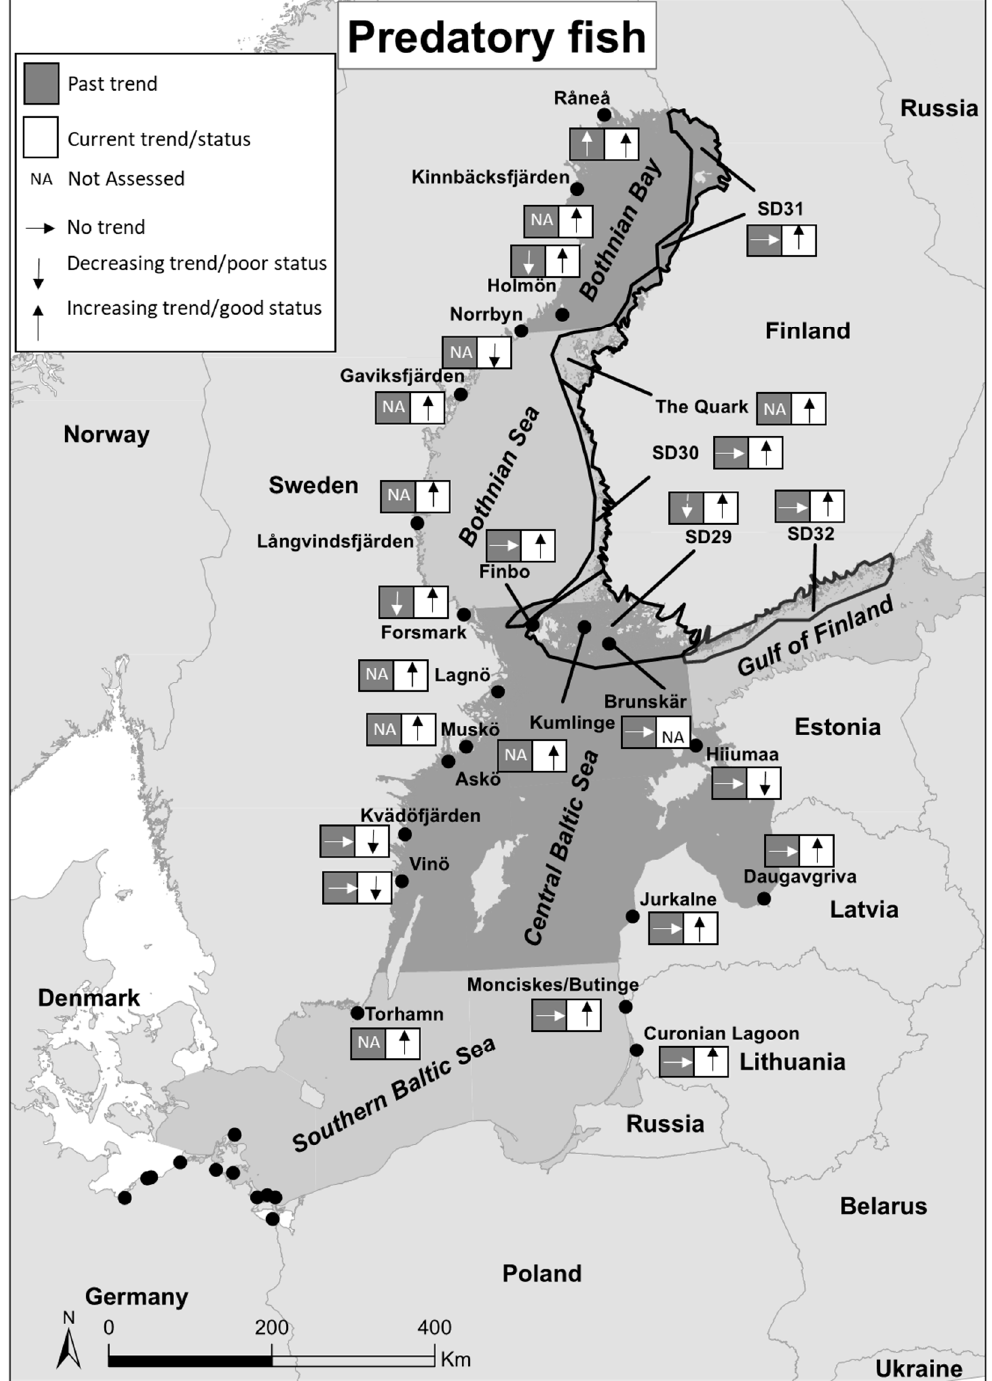
Figure 1. Overview of the status/trends in abundance of coastal predatory fish as a functional group for the areas in the Baltic Sea for which information (publications, regional status assessments or unpublished data - in Germany only) are available. For the coast of Germany, see Figure 2. An up-ward pointing arrow denote good status or increasing trends in abundance, a horizontal arrow no trend in abundance, and a down-ward pointing arrow poor status or decreasing abundance. NA denotes that no assessment/data is available. For each area, past trends (before 2007) are shown in a grey box, and the current status (after 2008) are shown in a white box. For the source of information for each area see the main text and Table 1.